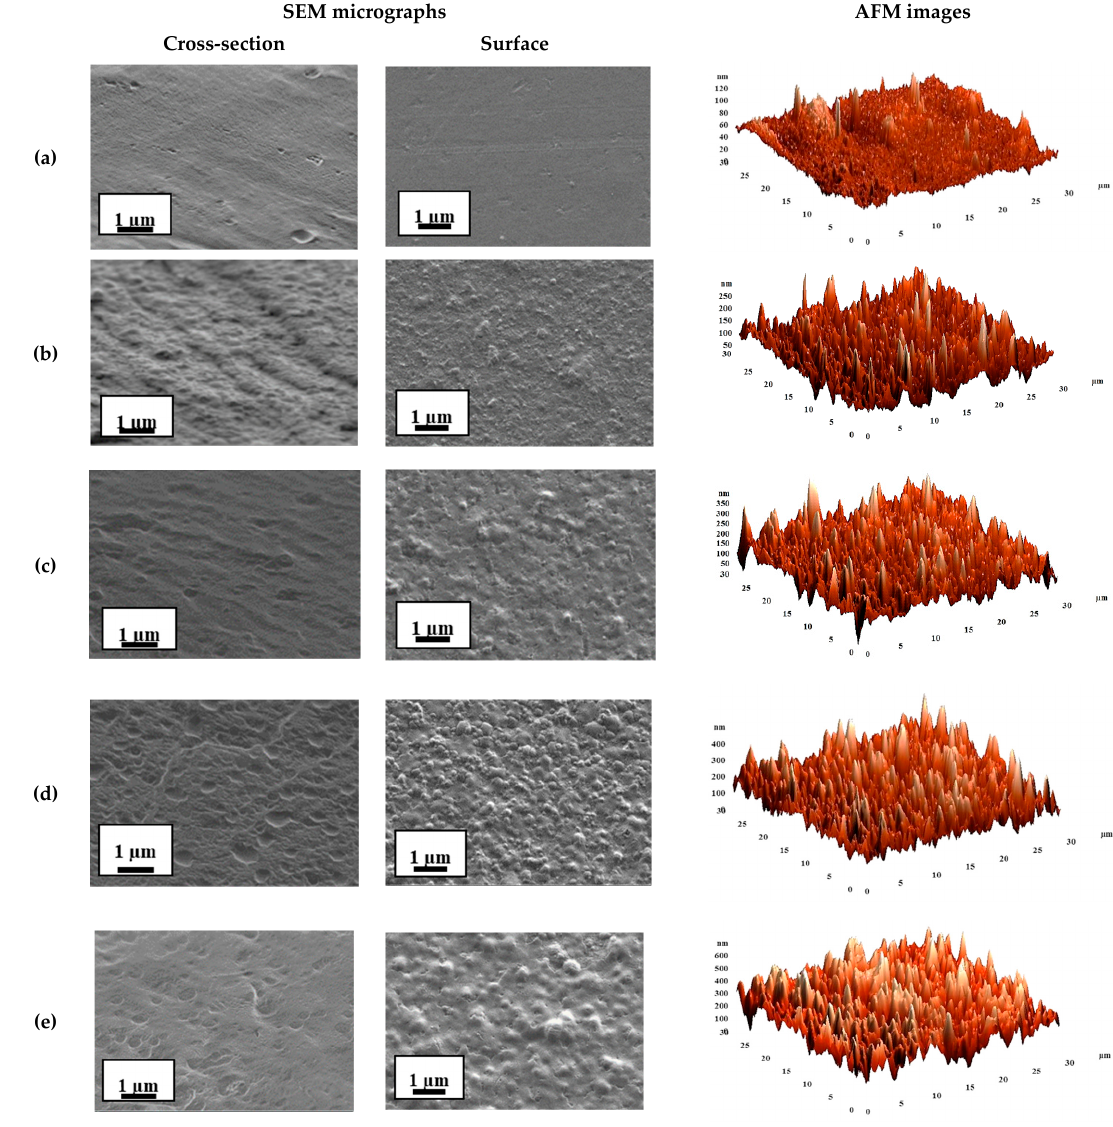
Figure 7. The cross-sectional and surface SEM micrographs and AFM images of the SA-based membranes: ( a ) SA, ( b ) SA-3, ( c ) SA-5, ( d ) SA-7, ( e ) SA-10. membranes: ( a ) SA, ( b ) SA-3, ( c ) SA-5, ( d ) SA-7, ( e )